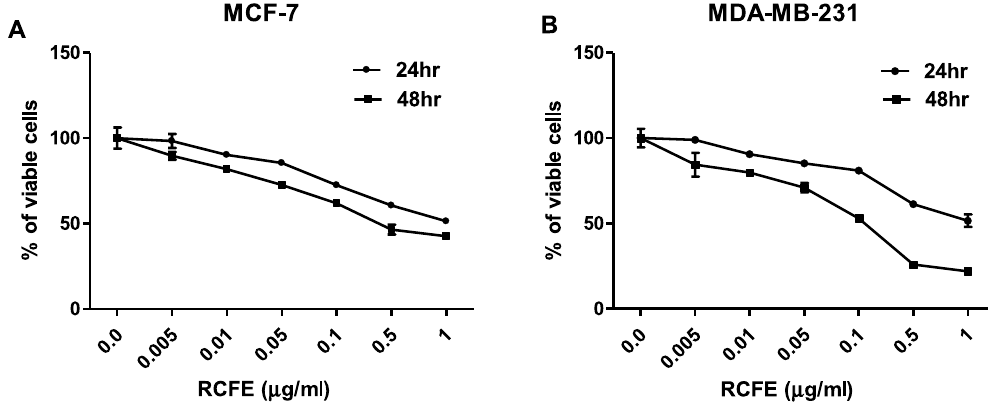
Figure 1. RCFE induced cytotoxicity in breast cancer cells. MCF-7 ( A ) and MDA-MB-231 ( B ) cells were treated with various concentrations of RCFE for 24 and 48 hr. Data represent the mean ± SEM of three independent